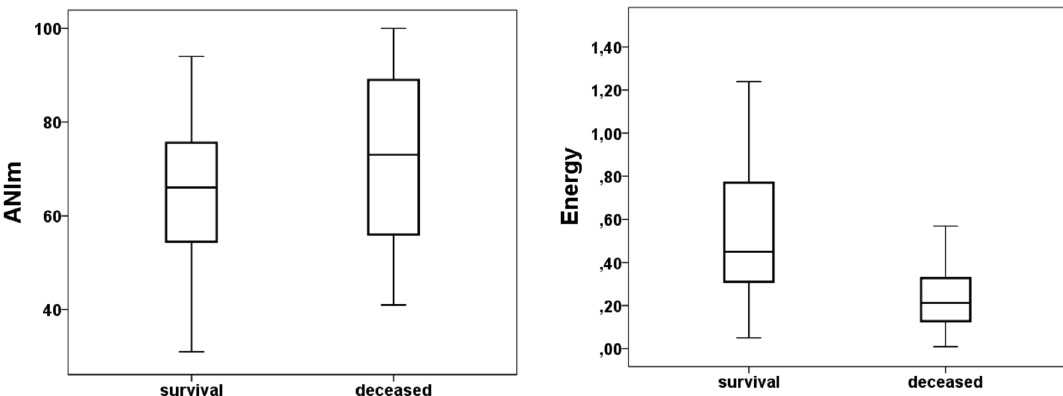
Figure 2. Box Plot for ANIm (left) and Energy (right). Box plot represents the median values of ANIm and Energy in both groups. ANIm, mean analgesia nociception index.